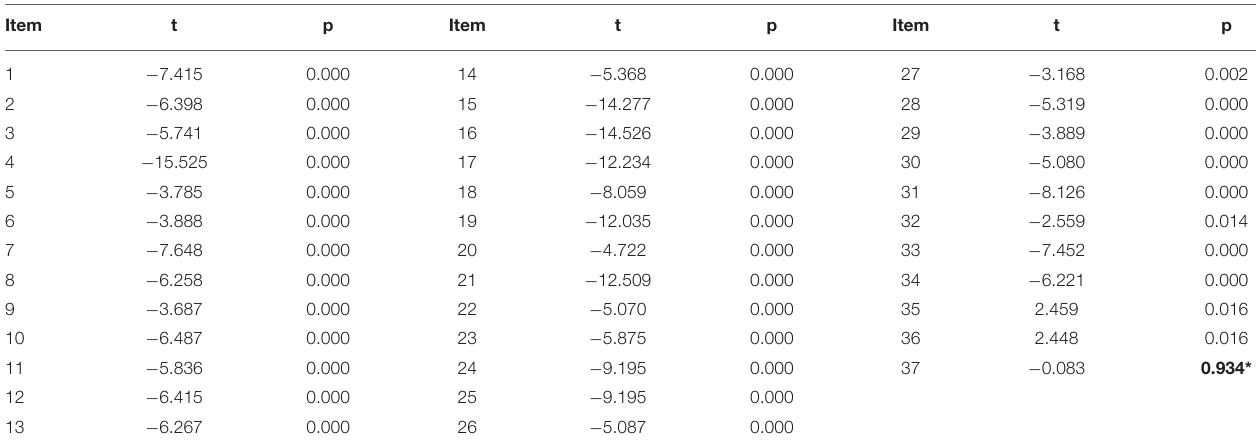
TABLE 3 | Test of differences between low and high groups ( N =